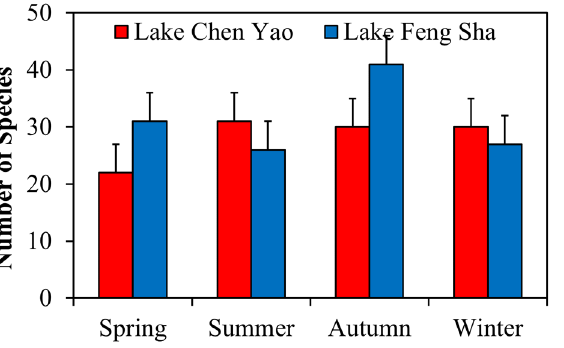
Figure 7. Seasonal distribution of zooplankton species in Lake Chen Yao and Lake Feng Sha.